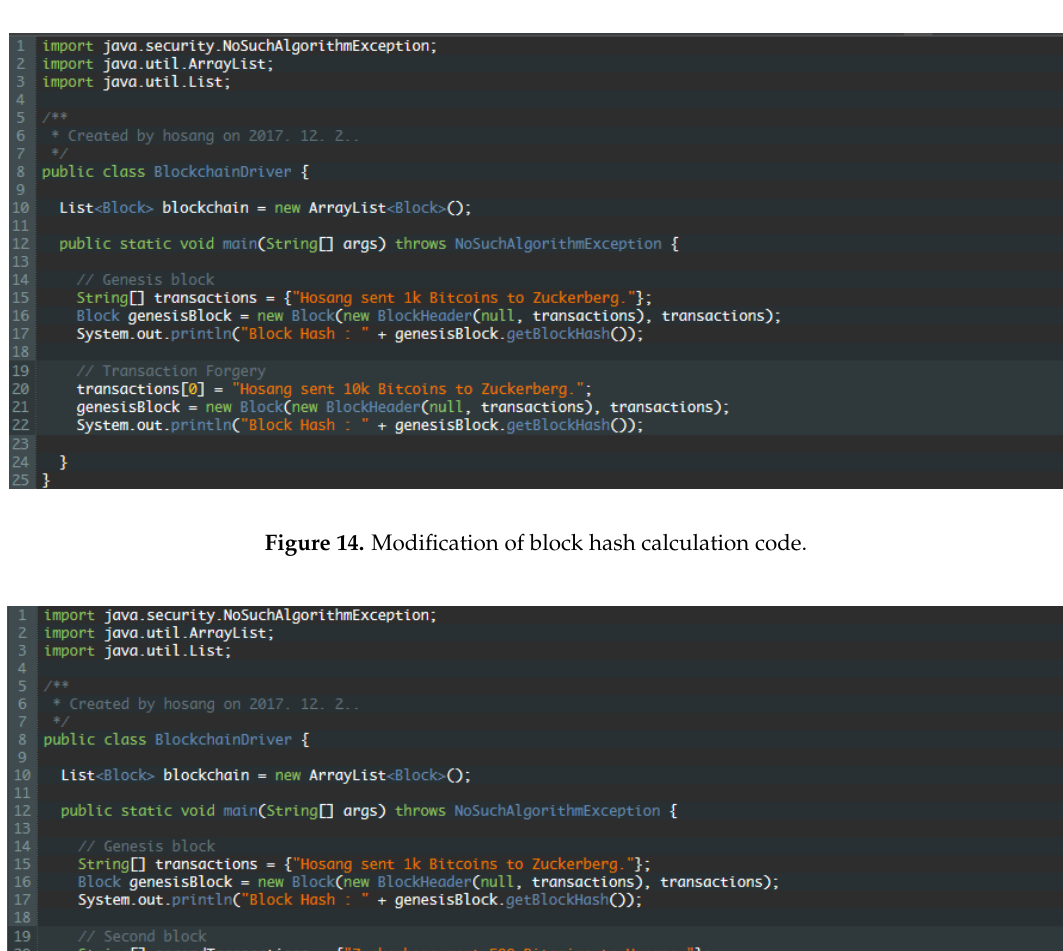
Figure 13. Block hash calculation.